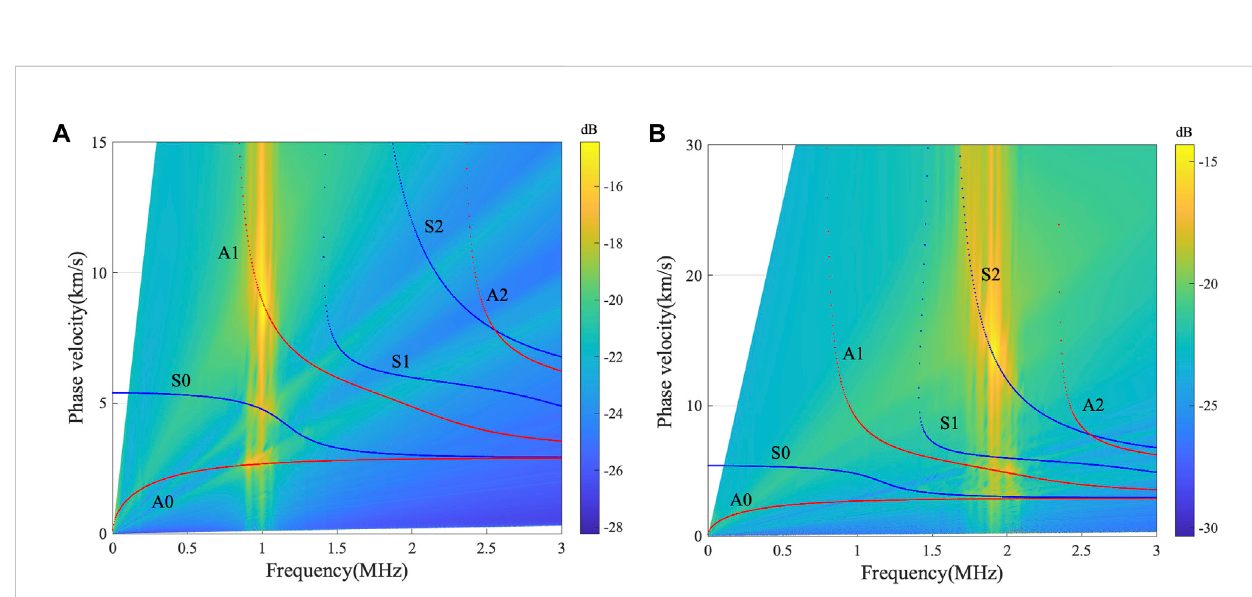
FIGURE 5 The dispersion curves and the two-dimensional Fourier transform results from FEM models: (A) the A1 wave at 1 MHz, (B) the S2 wave at 1.9 MHz. The red and blue curves are corresponding to the anti-symmetric modes and symmetric modes of the Lamb wave, respectively.